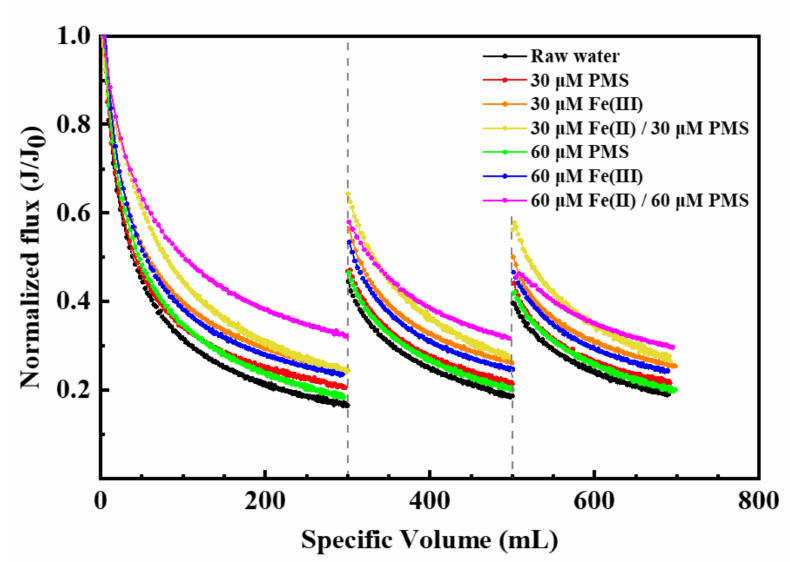
Figure 6. Changes of specific flux (J/J 0 ) with filtration volume (mL) under different concentration